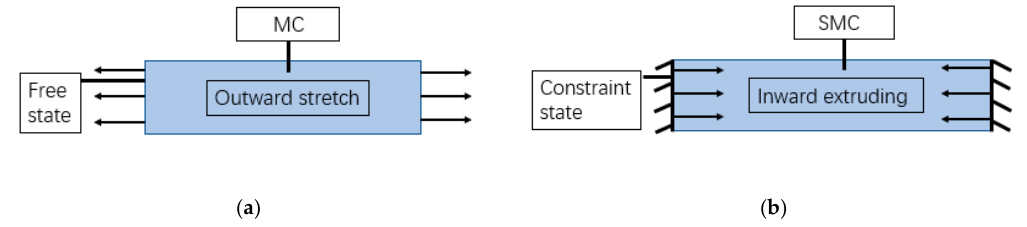
Figure 8. Expansion model of concrete: ( a ) Expansion under freedom,( b ) Expansion under constraint.